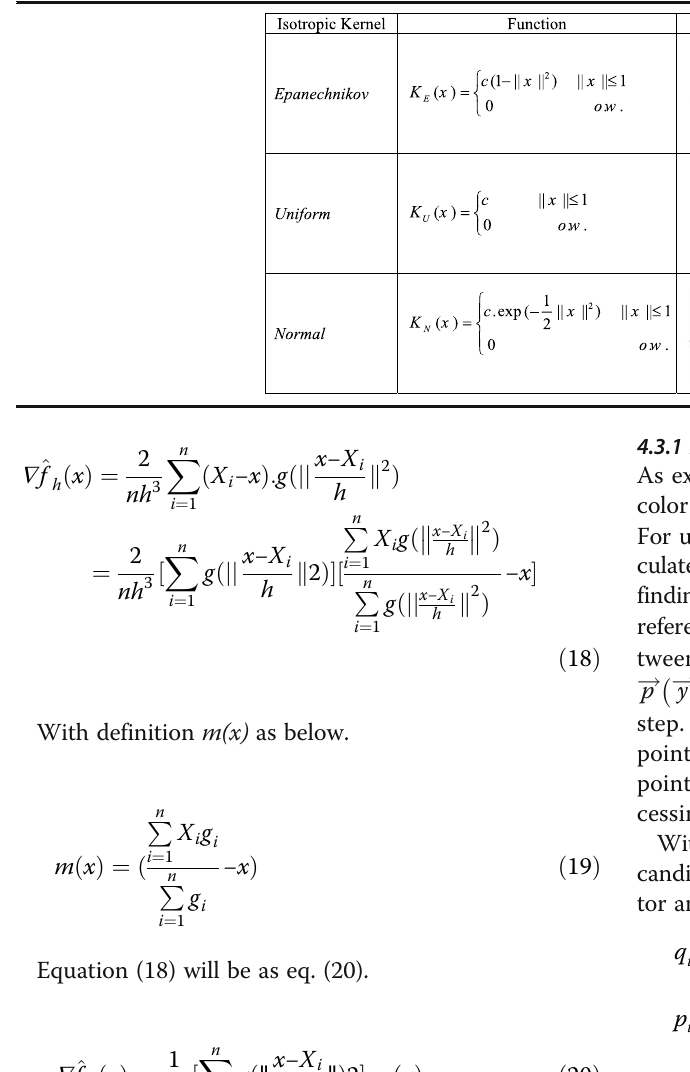
Table 1 Different isotropic kernel and their performance [36].